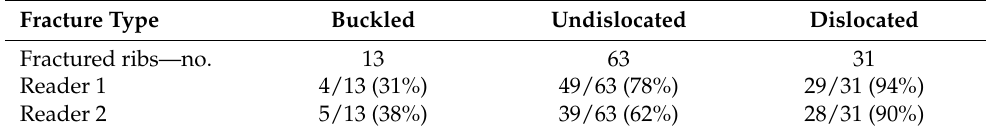
Table 4. Number of true-positive (TP) findings in the unfolded view for different fracture types. Fracture Type Buckled Undislocated Dislocated Fractured ribs—no. 13 63 Reader 1 4/13 (31%) Reader 2 5/13 (38%) 39/63 (62%) 28/31 (90%)